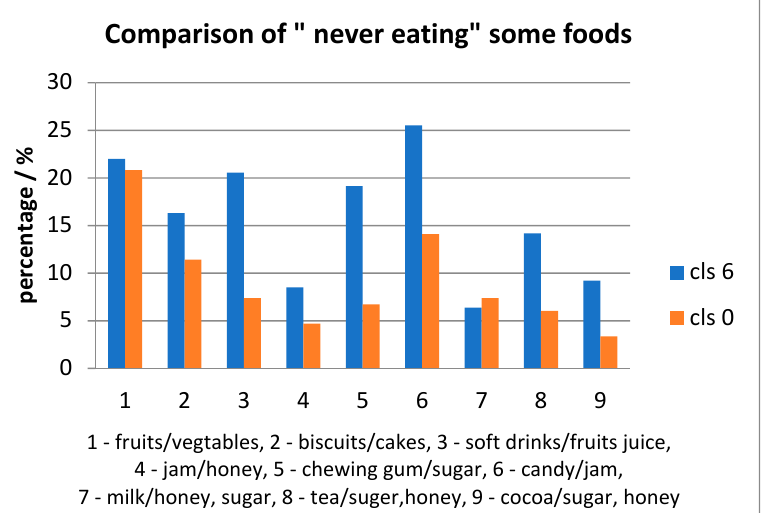
Table 7. ICDAS score registered for 6 and 12-year-old children consuming all nine foods listed. Figure 9. The eating habits in both age groups were compared to the “03”, “04”, “05”, “06”, “0A” ICDAS score of each child. There were statistically significant differences for: jam/honey ( p = 0.001149) and chewing gum with sugar ( p = 0.03749) consumed several times daily with higher scores for grade 0 than 6th grade. Another statistically significant difference was for biscuits/cakes/sweet pies ( p = 0.011009), soft drinks/fruits juice ( p = 0.025494), jam/honey ( p = 0.0223456), chewing gum with sugar